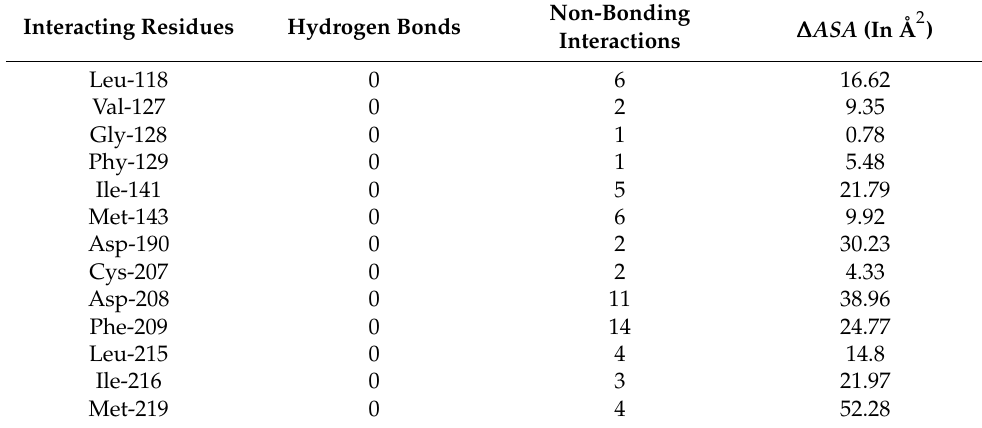
Table 5. The MEK1 residues interacting with the selected flavonoid (CID: 10524567) are listed with the number of non-bonding interactions and ∆ ASA